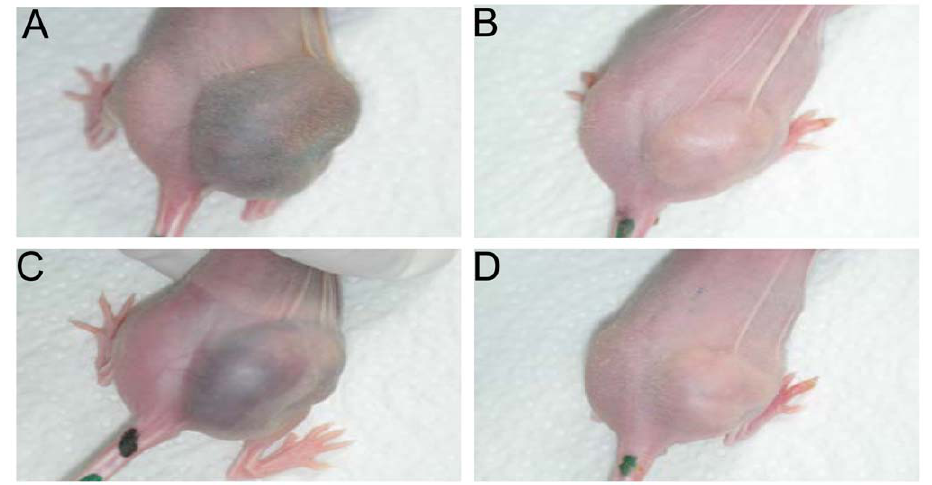
Figure 4. Phenotypic difference between GLV-1h68- and non-treated PLC-tumor-bearing mice. Pictures were taken at day 18 after injection with PBS (mock) (A, C) or GLV-1h68 (B, D).